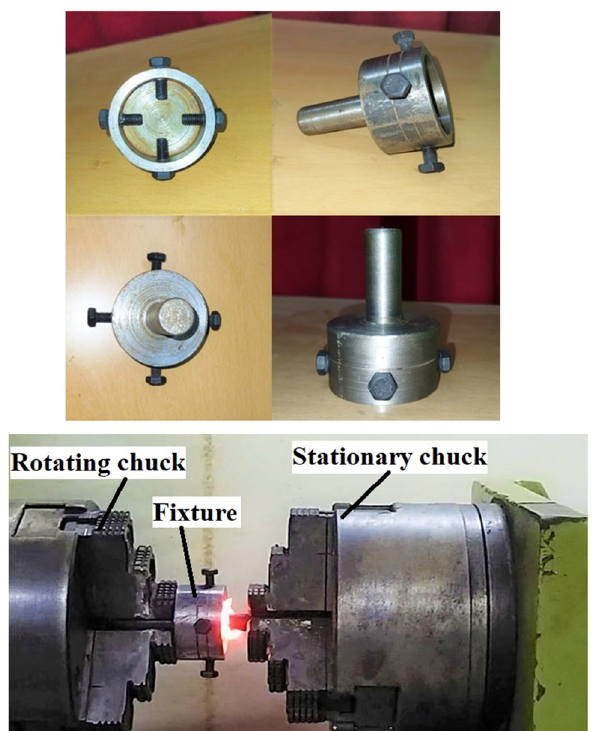
Figure 4: Photograph of fi xture developed to hold the AISI 1018